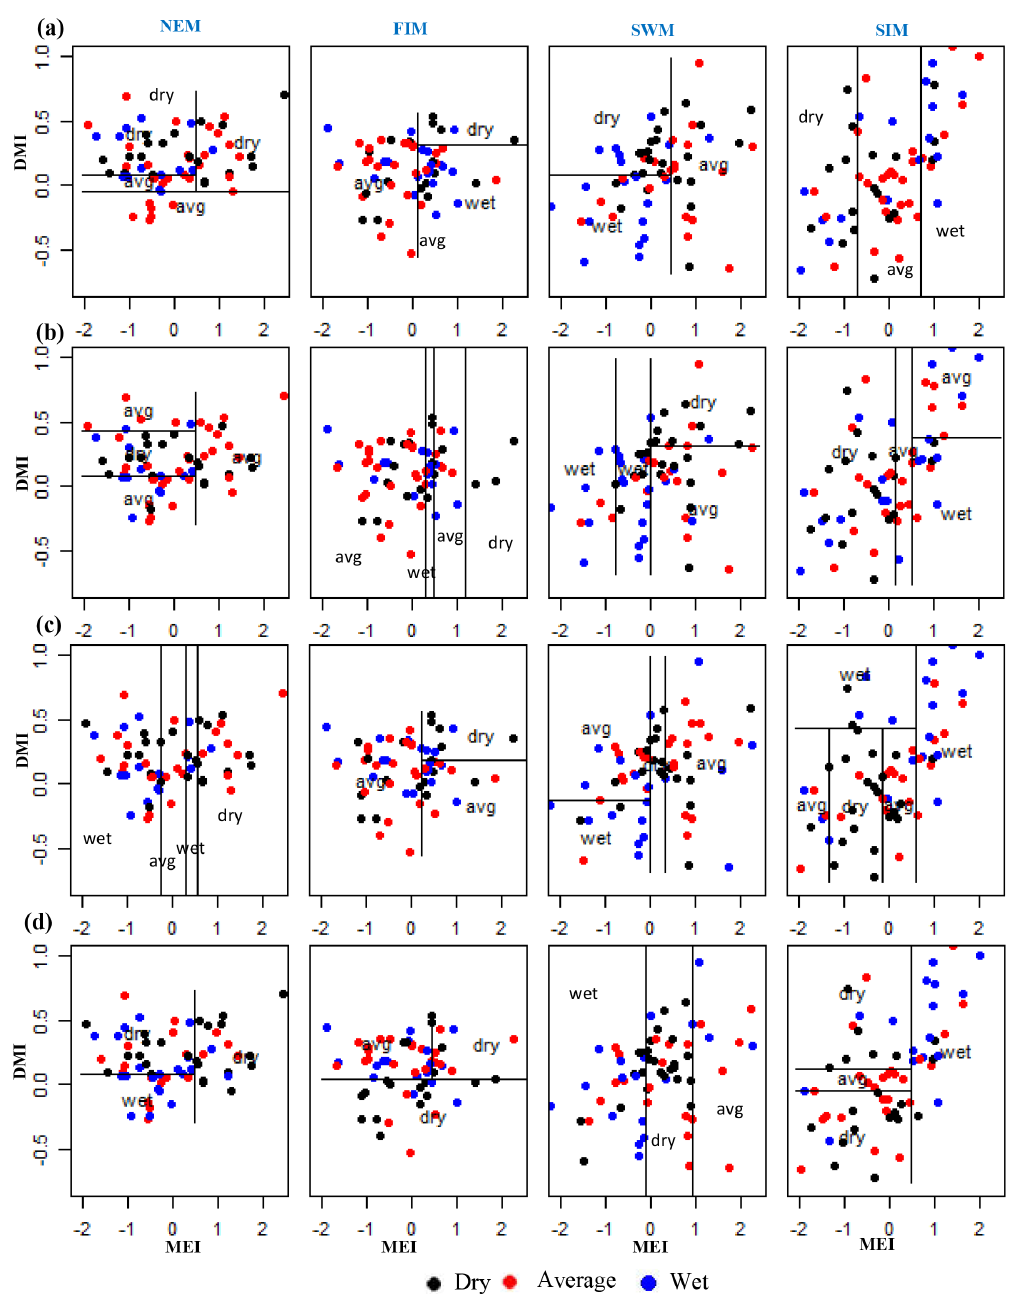
Figure A4. Identifying relationships between three rainfall classes (dry, average, wet) and MEI and DMI values using classification tree models. (a) Morape, (b) Peradeniya, (c) Randenigala, and (d)